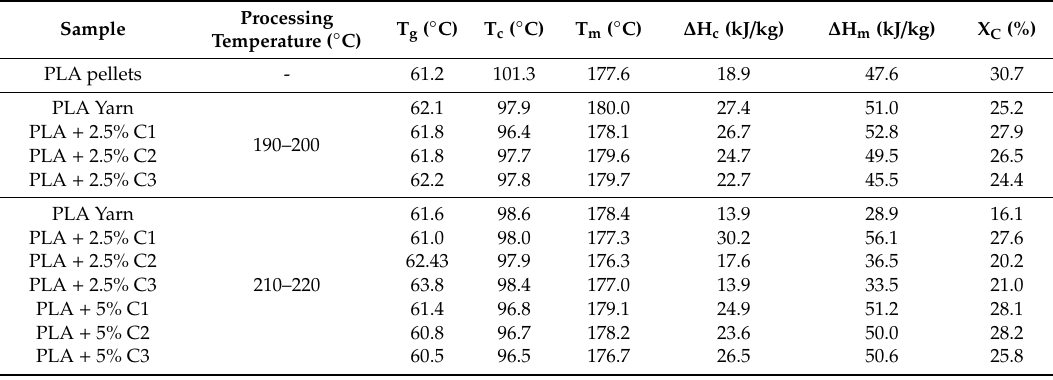
Table 3. Transition temperatures (glass transition temperature T g , crystallization temperature T c and melting temperature T m ), enthalpies and crystallinity degree of the samples after di ff erent conditions of processing obtained from the first heating cycle with a rate of 10 ◦ C min − 1